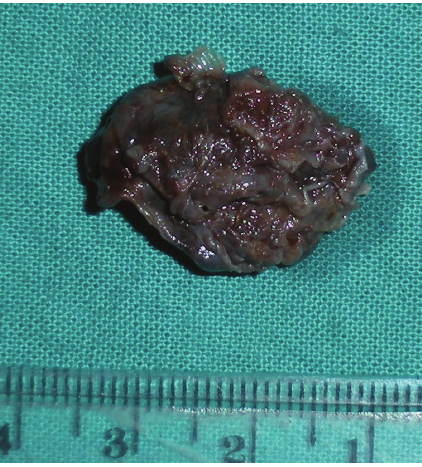
Figure 6: Gross specimen of the enucleated cyst.